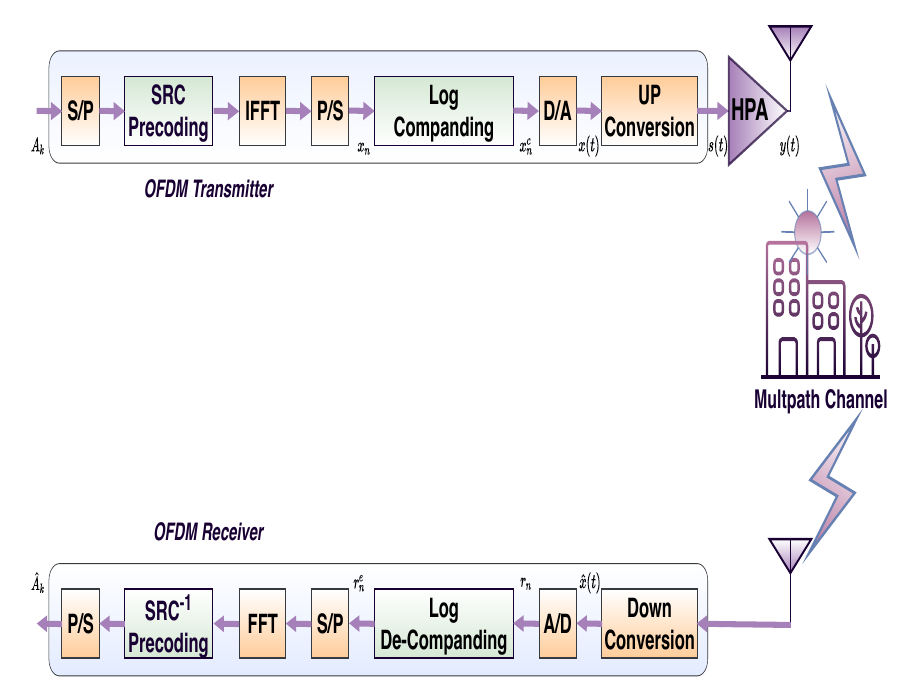
Figure 2. General block diagram of SRC-Log-based OFDM